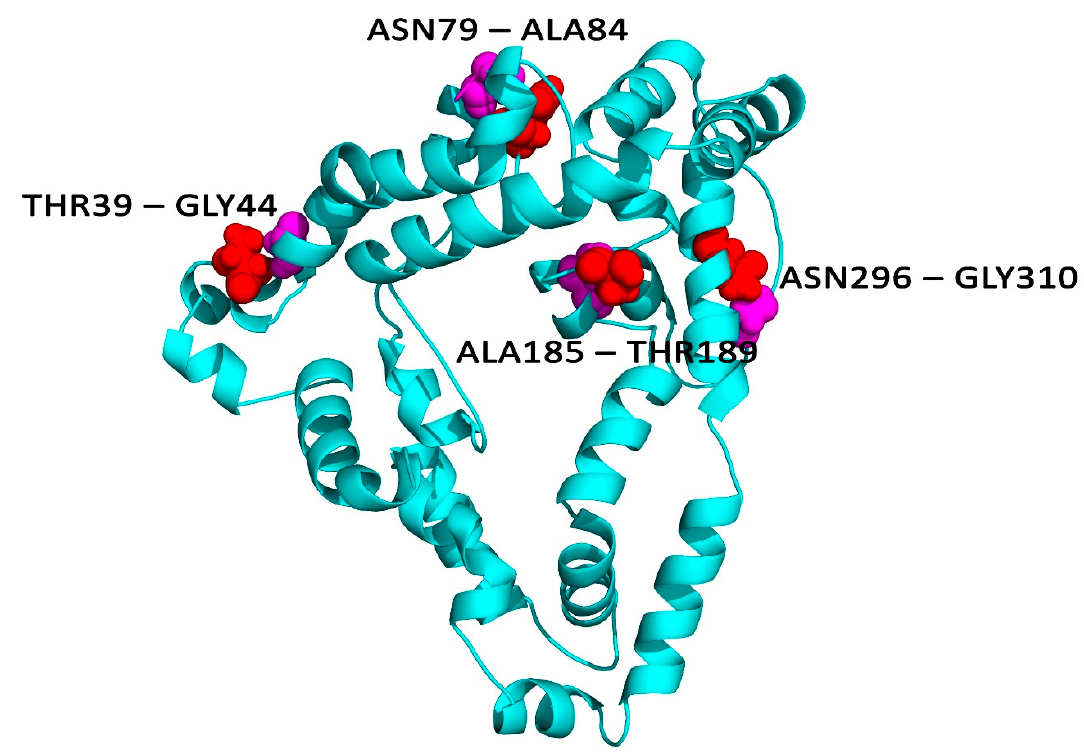
Figure 6. Disulphide engineering of the vaccine protein. Residue pairs showed in red (THR39, ASN79, ALA185, ASN296) and magenta (GLY44, ALA84, THR189, GLY310) spheres were mutated to Cysteine residues to form disulphide bridge between them.